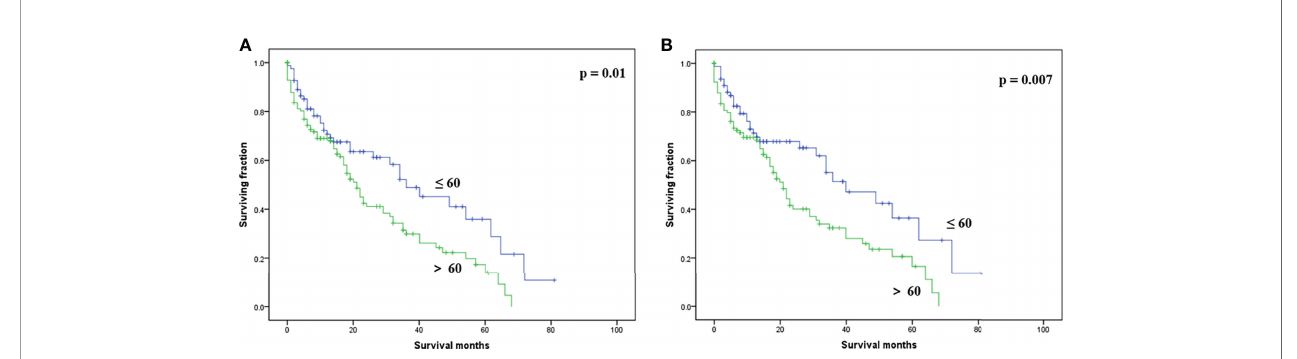
FIGURE 2 | Kaplan – Meier method-estimated OS (A) and CSS (B) male breast cancer with bone metastasis strati fi ed by age. (OS, overall survival; CSS, cancer- speci fi c survival).